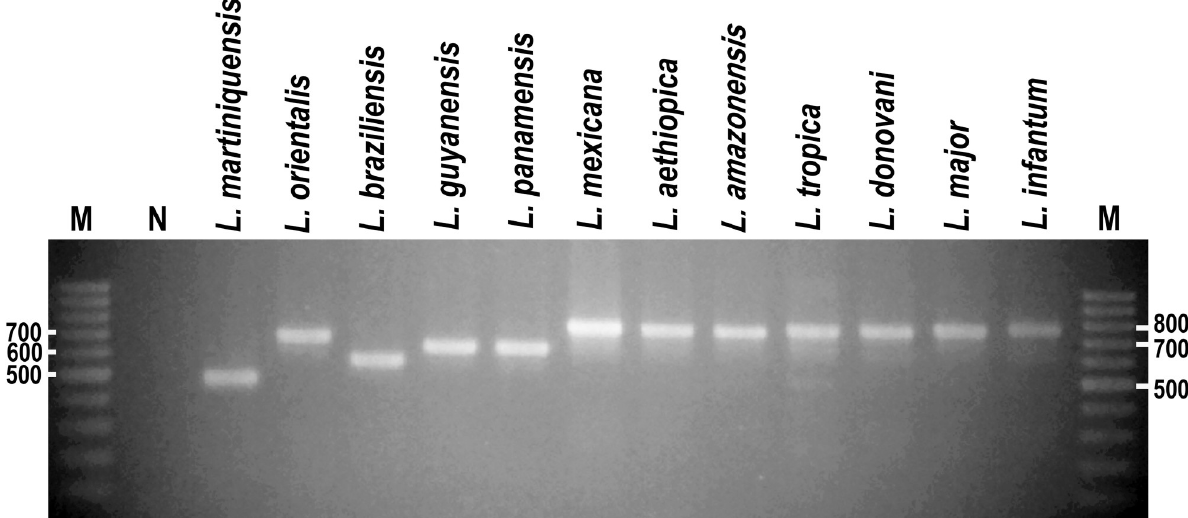
Fig 1. Agarose gel electrophoresis of HSP70-I -3 0 -UTR PCR products of 12 Leishmania species. M = Molecular markers and N = Negative control.